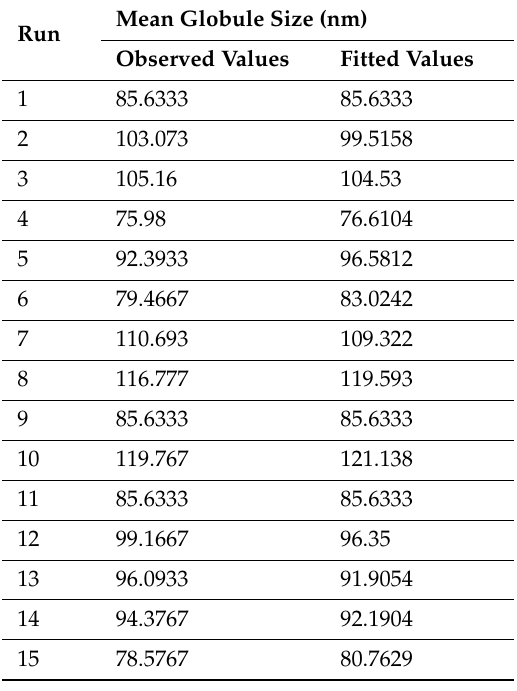
Table 3. Data for the actual and fitted values of mean globule